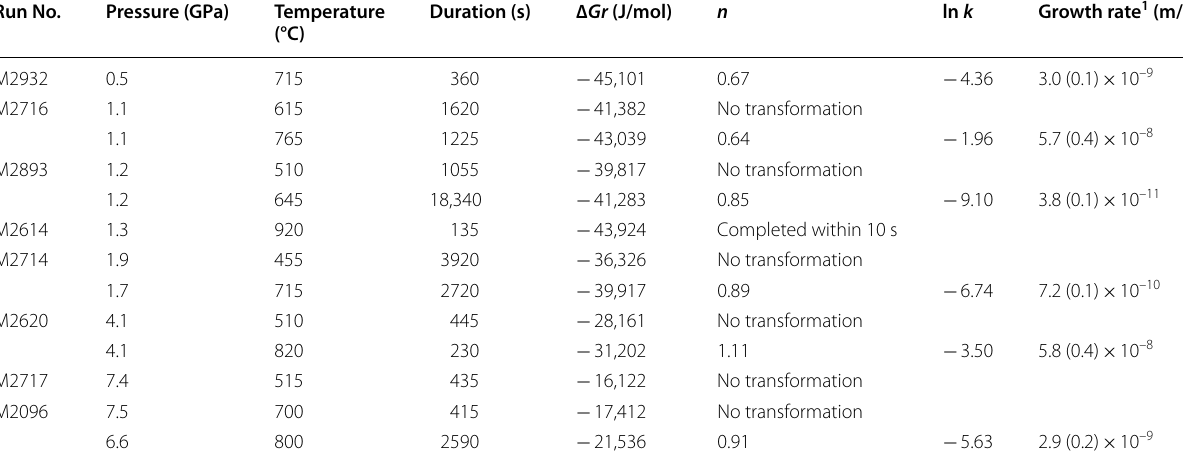
1 The uncertainties in growth rate are listed in parentheses